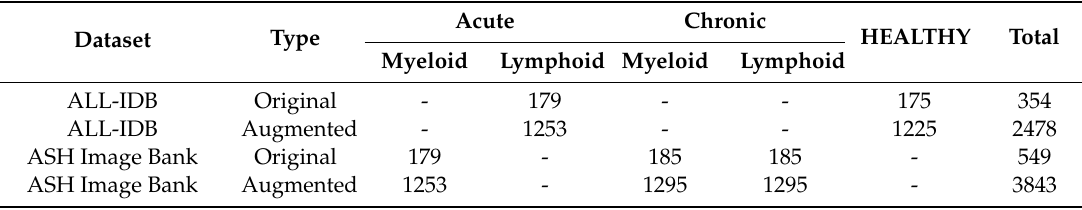
Table 1. Dataset coverage for four leukemia subtypes and HEALTHY image samples. The original rows indicate the initial sample numbers, the augmented rows show the increased number of samples by using data